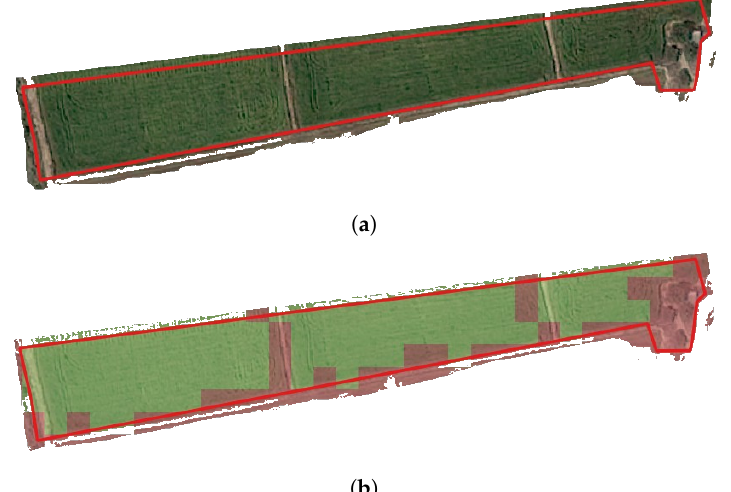
Figure 8. Example of error detected in the quality assessment on the cardinality batch. ( a ) Orthophoto on the enclosure with the wrong traffic light colour in cardinality. ( b ) Classification by RF on the enclosure with the wrong traffic light colour in cardinality.